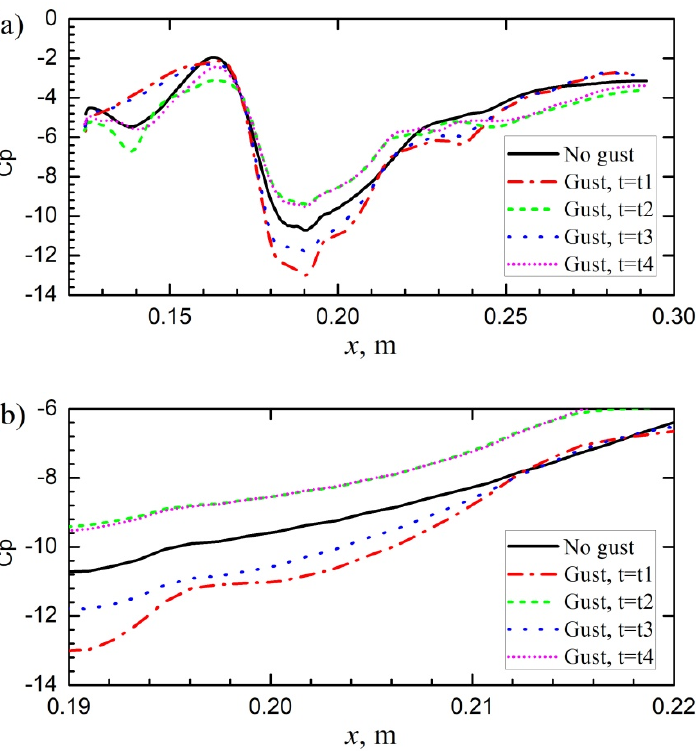
Figure 20. Static pressure distributions on the top surface of the inlet under the no-gust condition and at different phases of the gust ( f = 100 Hz and (cid:101) u g = 8 m/s) at M = 0.235 and p AIP / p 0 = 0.85: ( a ) the overall view and ( b ) amplified view in the adverse-pressure-gradient zone.